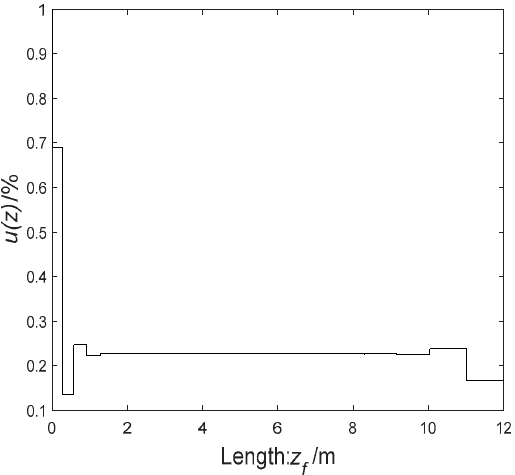
Figure 11. Optimal control trajectory ( N = 20).